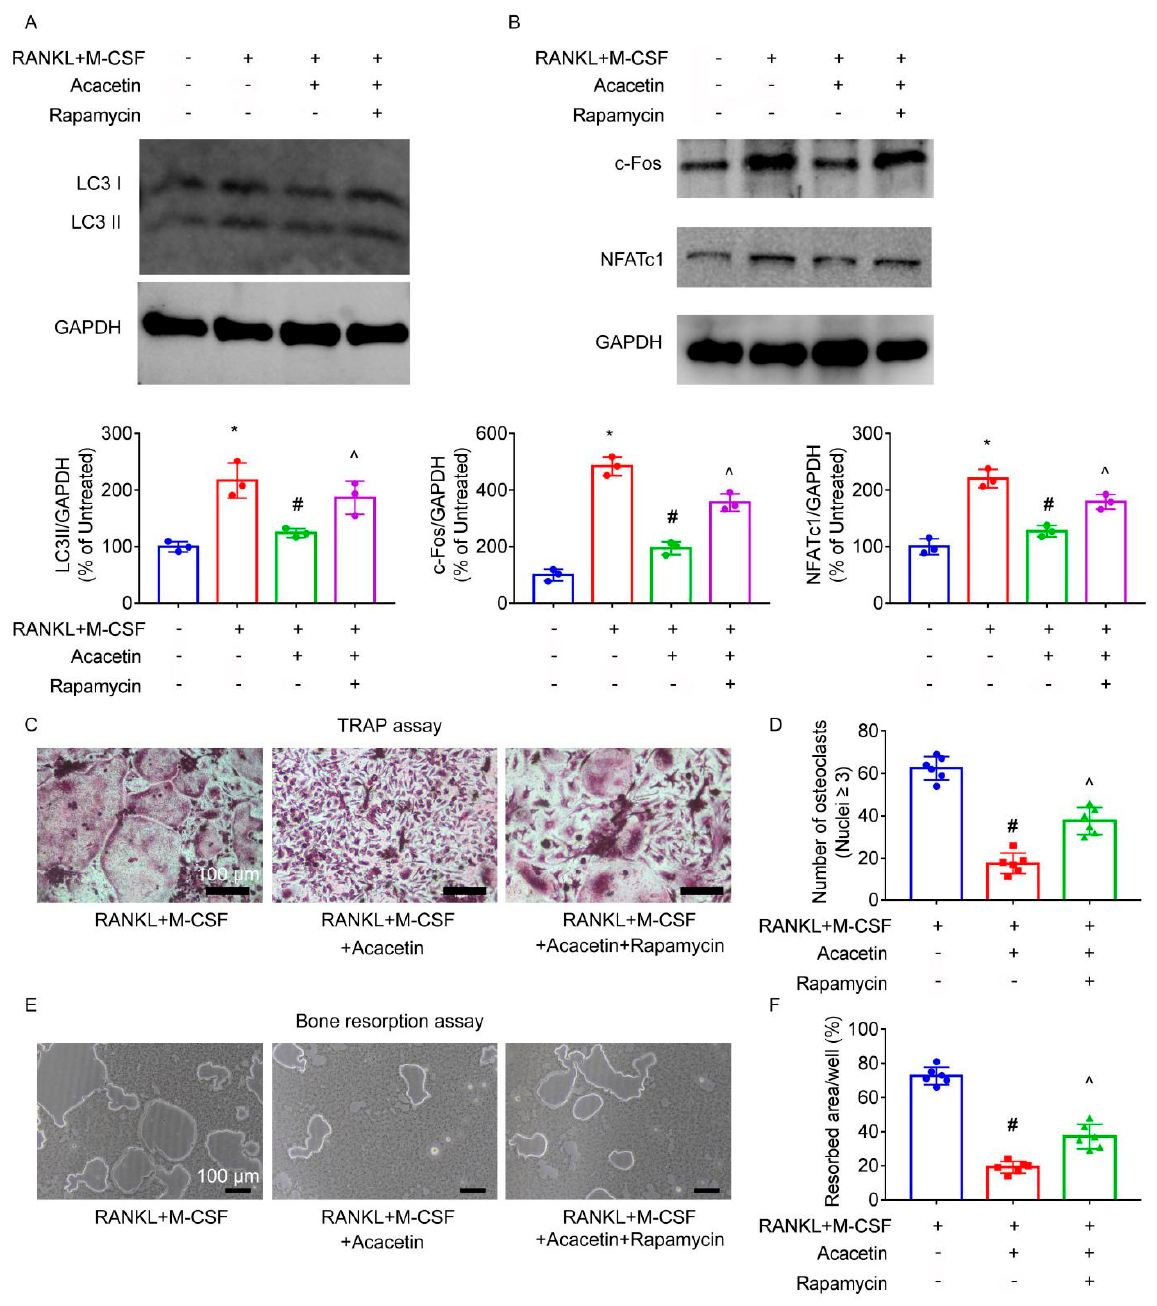
Figure 6. Activation of autophagy by rapamycin abolished the effect of acacetin on osteoclast differentiation and bone resorption in vitro. BMMs were stimulated with RANKL (50 ng/mL) and M-CSF (25 ng/mL) in the presence of acacetin (25 µ M) and rapamycin (50 nmol/L) for 6 h. Protein expression of LC3 ( A ) was detected by western blotting analysis. BMMs were stimulated with RANKL (50 ng/mL) and M-CSF (25 ng/mL) in the presence of acacetin (25 μ M) and rapamycin (50 nmol/L) for 3 days. Protein expression of c-Fos and NFATc1 ( B ) was detected by western blotting analysis. BMMs were stimulated with RANKL (50 ng/mL) and M-CSF (25 ng/mL) in the presence of acacetin (25 μ M) and rapamycin (50 nmol/L) for 7 days. TRAP-positive multinucleated osteoclasts ( ≥ 3 nuclei) were counted using TRAP assay ( C , D ). BMMs were seeded in Osteo Assay Surface plate and stimulated with RANKL (50 ng/mL) and M-CSF (25 ng/mL). After immature osteoclasts were formed, acacetin (25 μ M) and rapamycin (50 nmol/L) were added for 3 days. Bone resorption area was quantified ( E , F ). * p < 0.05 versus the vehicle-treated group; # p < 0.05 versus the RANKL+M-CSF group; ^ p < 0.05 versus the RANKL+M-CSF+acacetin group.